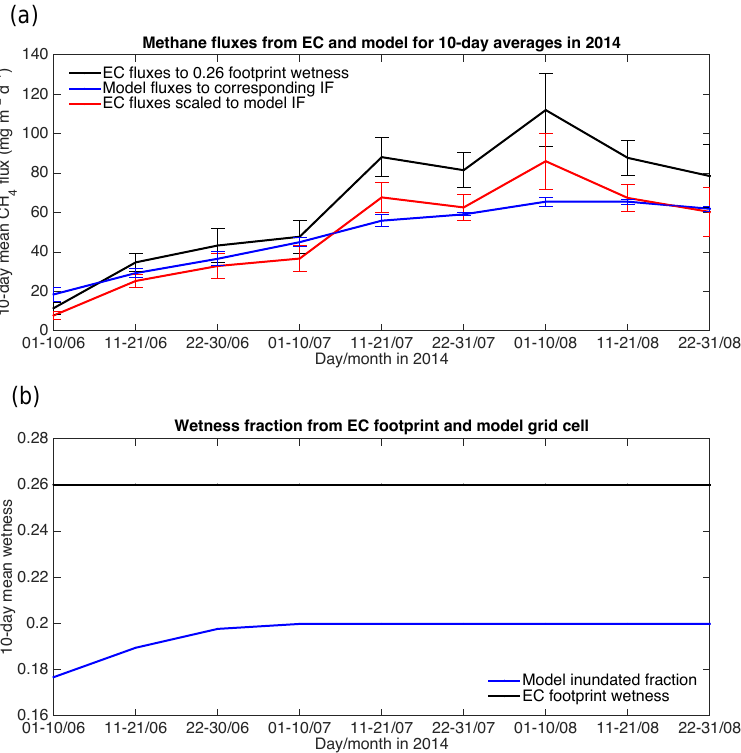
Figure A2. (a) Non-scaled 10-day mean EC methane fluxes representing emissions from 26% of a wet area in the footprint between June and August 2014 (black line), the 10-day mean EC methane fluxes scaled to the 10-day mean inundated fraction (IF) from the model for the same period of time (red line), and 10-day mean model methane emissions for grid cell A, which imply emissions from the IF from the model (blue line). Error bars in all lines are 1 standard deviation of the 10-day mean flux values; (b) shows the 10-day mean IF from the model used to scale the EC fluxes (blue line) and the constant wetness percentage of the footprint area calculated from the vegetation coverage remote sensing images (i.e.,